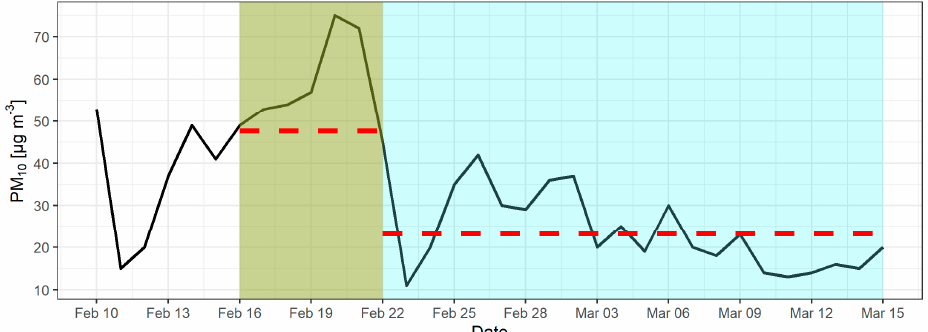
Figure 4. Measured daily PM 10 concentrations in the observed period from 10 February to 15 March 2019, collected from AWS-B. Persistent ATI period with a latent increase of PM concentrations shaded green, the post-ATI period included in the analysis shaded blue. Dashed red lines show mean PM 10 values for each period.